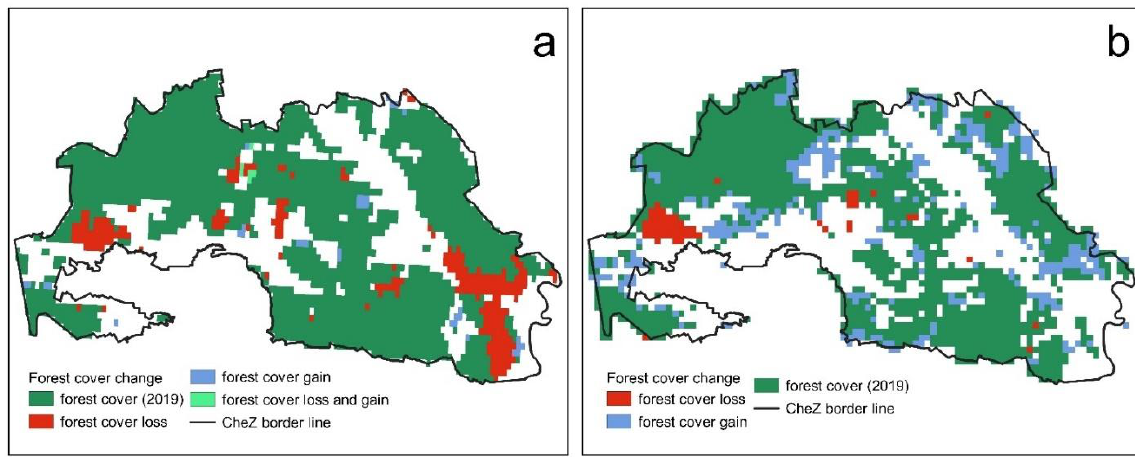
Figure 10. ( a ) Historic Land Dynamics Assessment (HILDA [29]) forest cover change data for the period 1960–2019 vs. ( b ) our forest cover change product for the period 1986–2019. The spatial resolution of both maps is 1 km 2 .